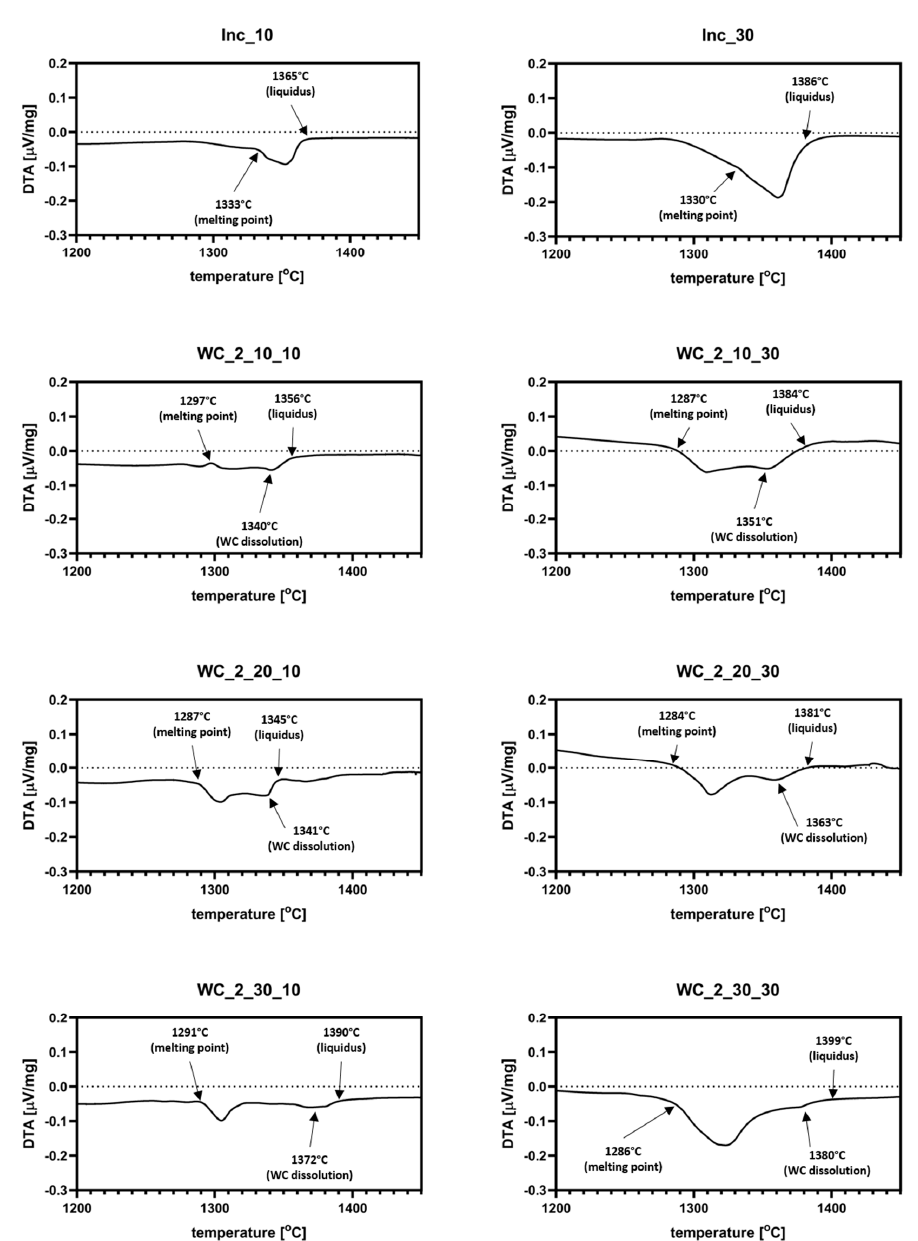
Figure 4. DTA thermograms for Inconel 625–WC_2 samples for 10 °C/min and 30 °C/min